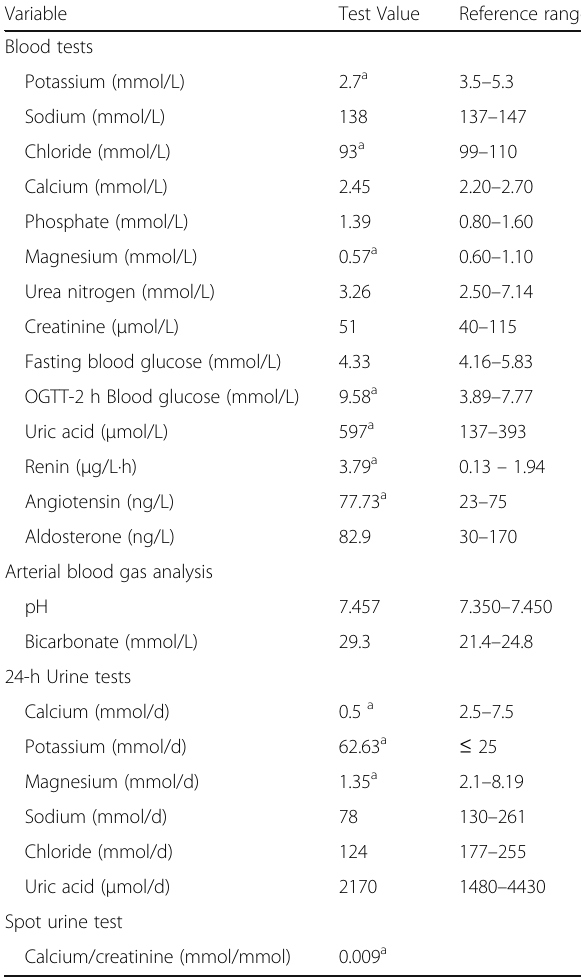
Table 1 Biochemical characteristics of the